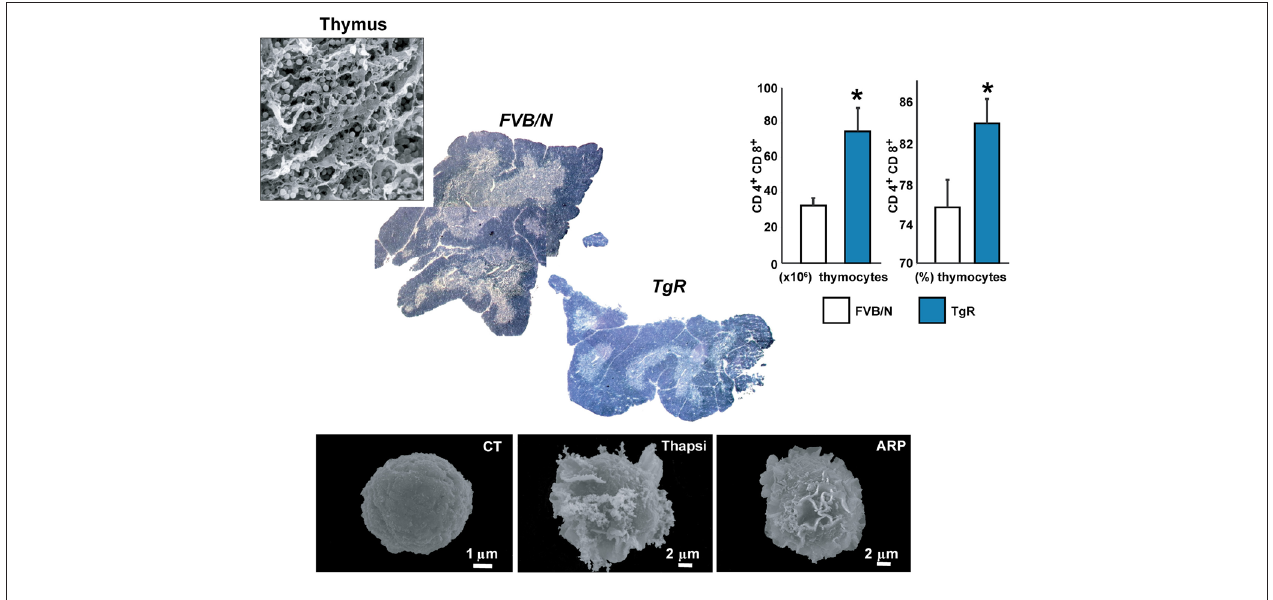
Below: Megakaryoblasts (Meg-01) cells scanned by electron micrographs. Control Meg-01 cells exhibit a smooth surface. Cells treated for 24h with ARP show initial formation of flat membrane sheets (middle panels) or elongated pseudopodia reflecting proplatelet formation territories (right panels) characteristic of megakaryocytic differentiation [Guimaraes-Sternberg et al.